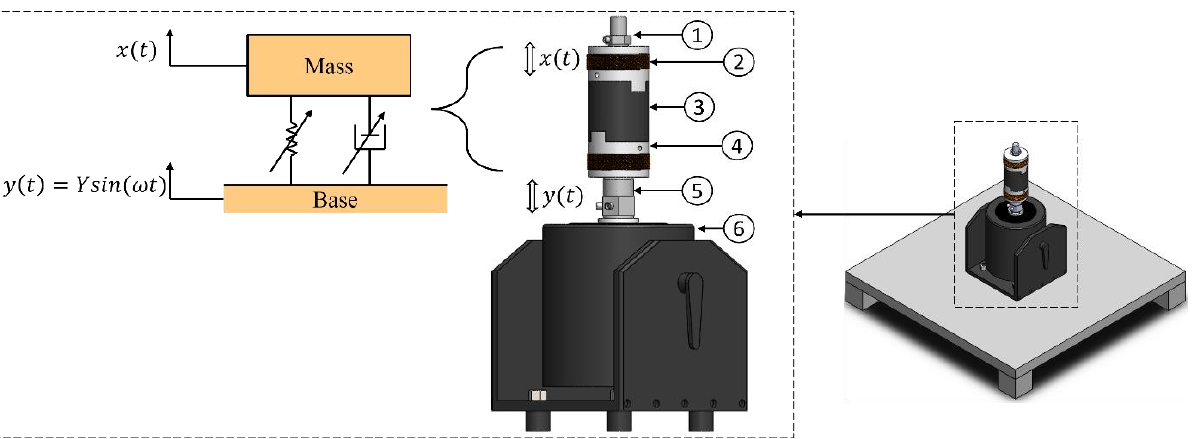
Figure 2. Model representing the base excitation of the hybrid MRE coupling: (1) accelerometer; (2) coils; (3) hybrid MRE; (4) coupling hub; (5) impedance sensor; (6) vibration shaker.